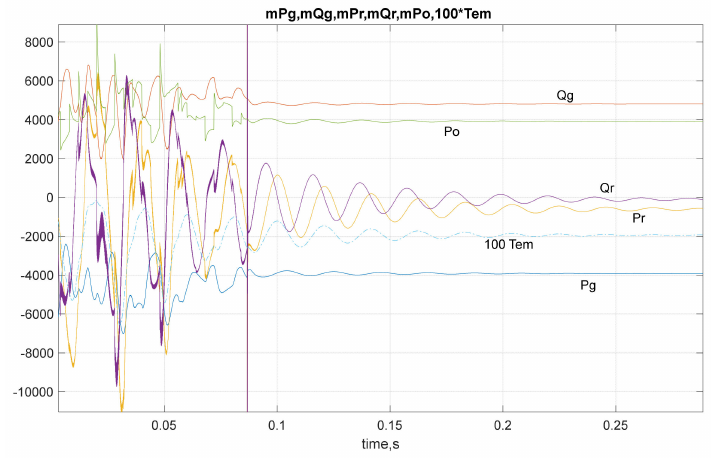
Figure 27. Active powers of stator Pg , rotor Pr and load Po and reactive powers of stator Qg , rotor Qr and the electromagnetic torque of generator DFIG (* 100) for protection a.